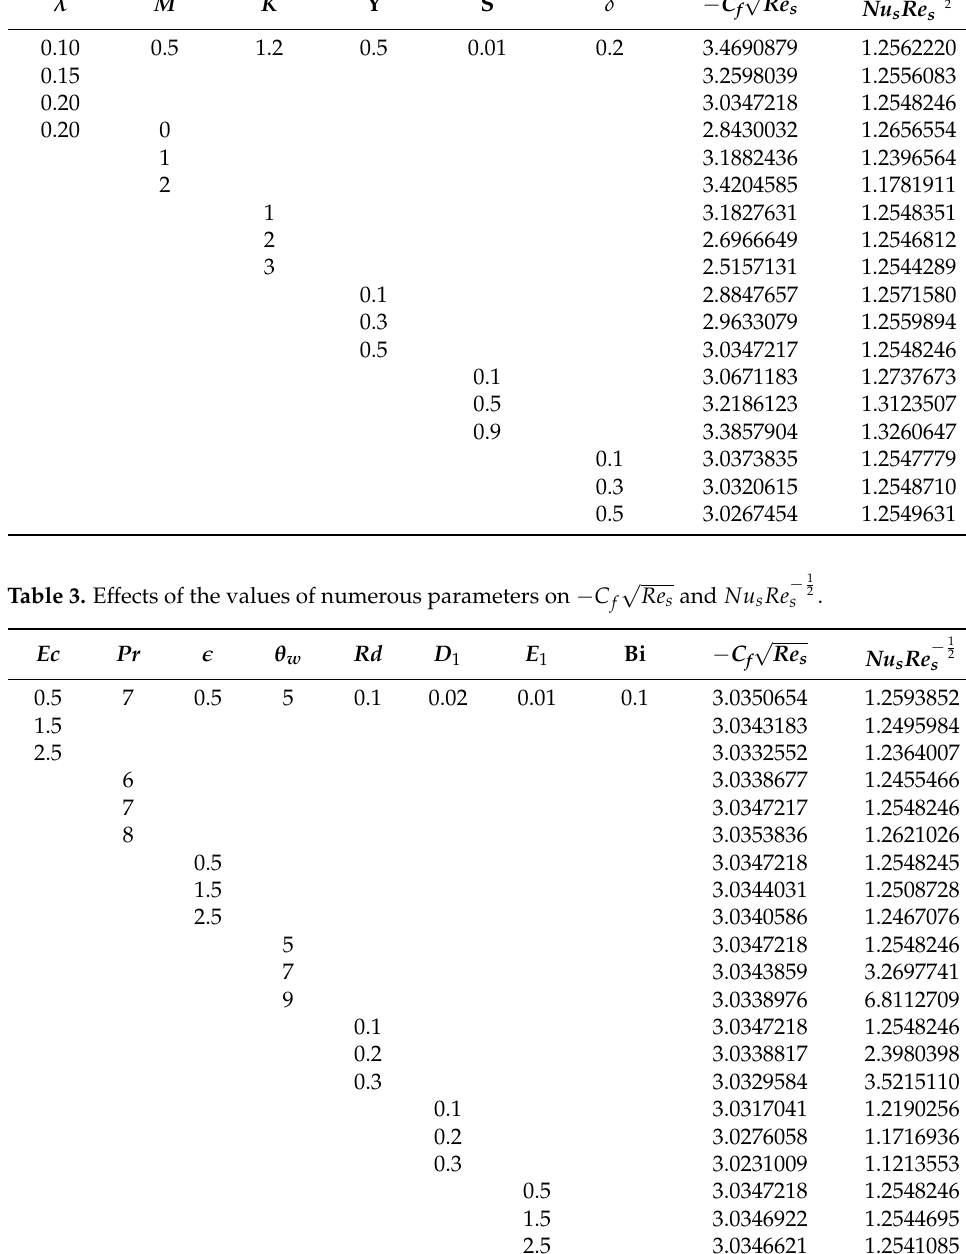
Table 2. Impact of various parameters on C f and Nu x .